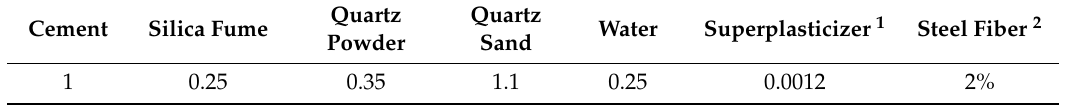
Table 2. Mix proportions of UHPFRC (by weight of cement).